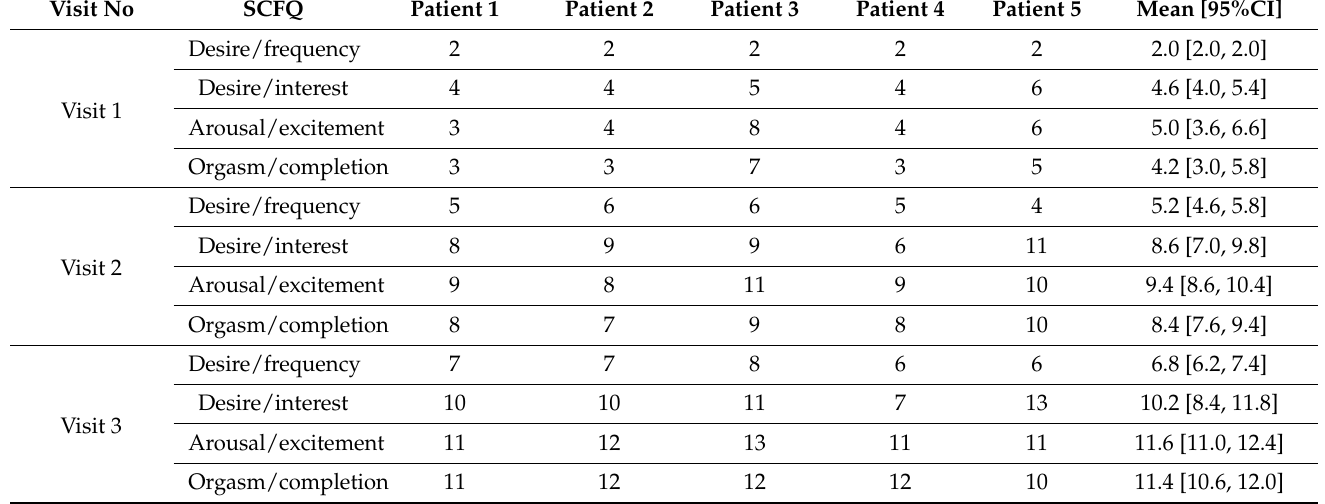
Table 2. Results in individual subscales of the patients’ CSFQ scale at subsequent